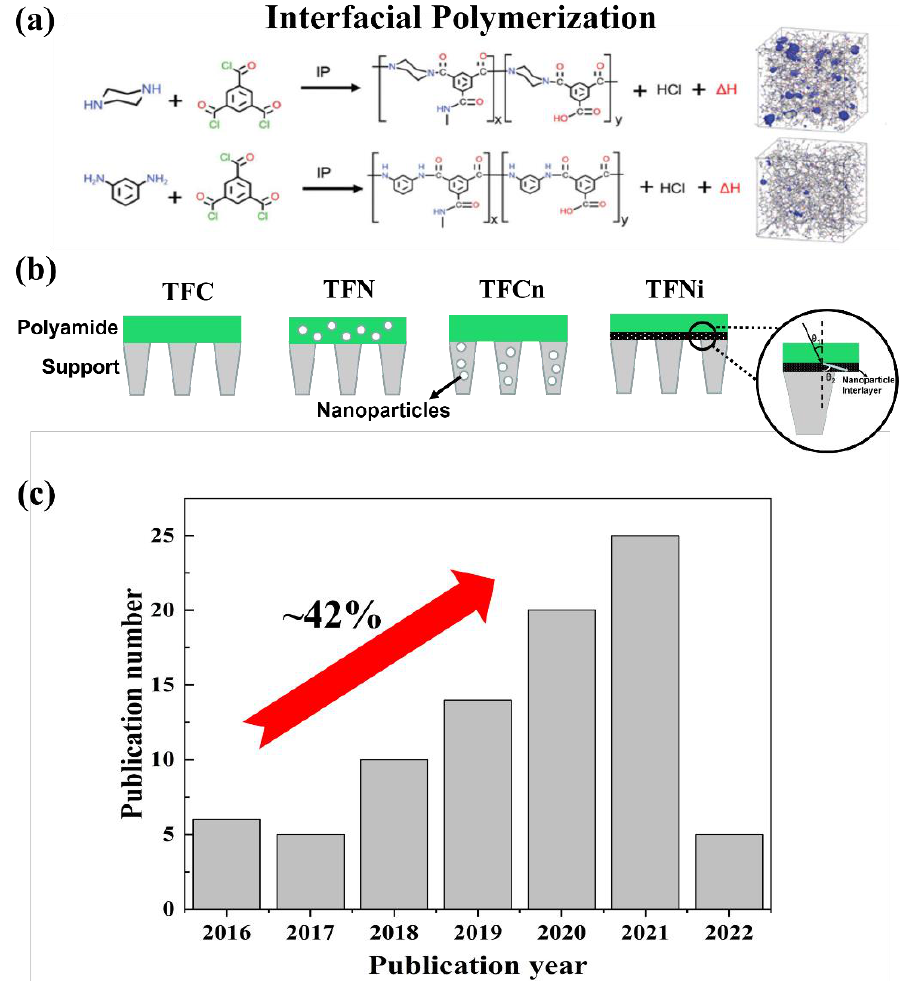
Figure 1. ( a ) Interfacial polymerization reactions between the 1,3-phenylenediamine or piperazine with the 1,3,5-benzenetricarbonyl trichloride, as well as the molecular structure of the corresponding PA layers from molecular dynamics simulations, reproduced with permission from Ref. [48] with copyright permission from © 2020 American Chemical Society; ( b ) schematic illustration of the structures of TFC, TFN, TFCn, and TFNi membranes; ( c ) Recent publications on the TFNi membranes with 2D interlayers. All data were obtained by searching the keyword “TFNi” in the database of Scopus, under May 2022, with further manual screening.